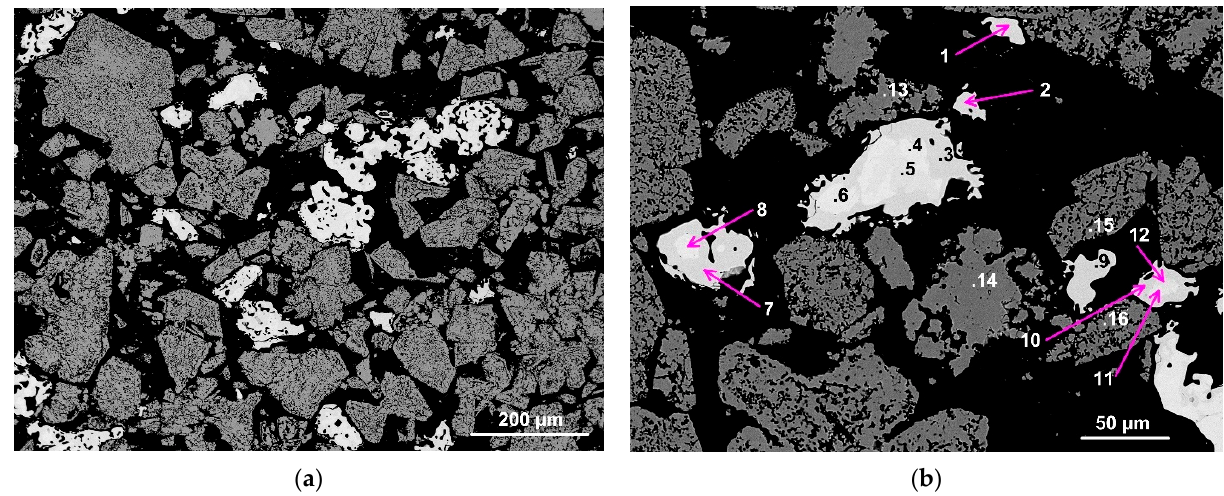
Figure 7. ( a ): Sample D BSE image: 1100 ◦ C, 15% Fe addition; ( b ): Magnified sample D analysis area BSE image: 1100 ◦ C, 15% Fe addition; (grey = MnO, white = alloy). Table 2. SEM-WDS analyses of points in Figure